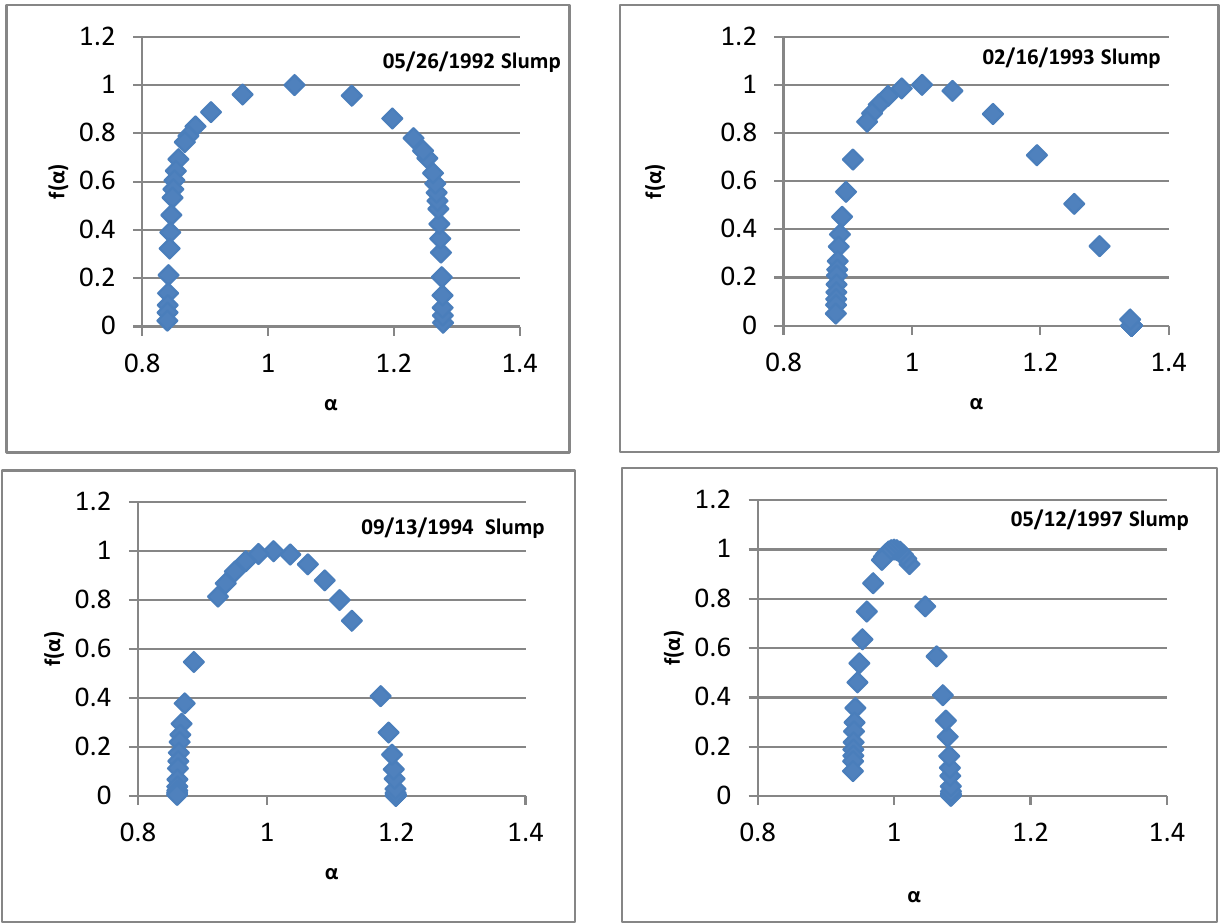
Figure 2. Generalized correlation dimensions Dq with different values of q.